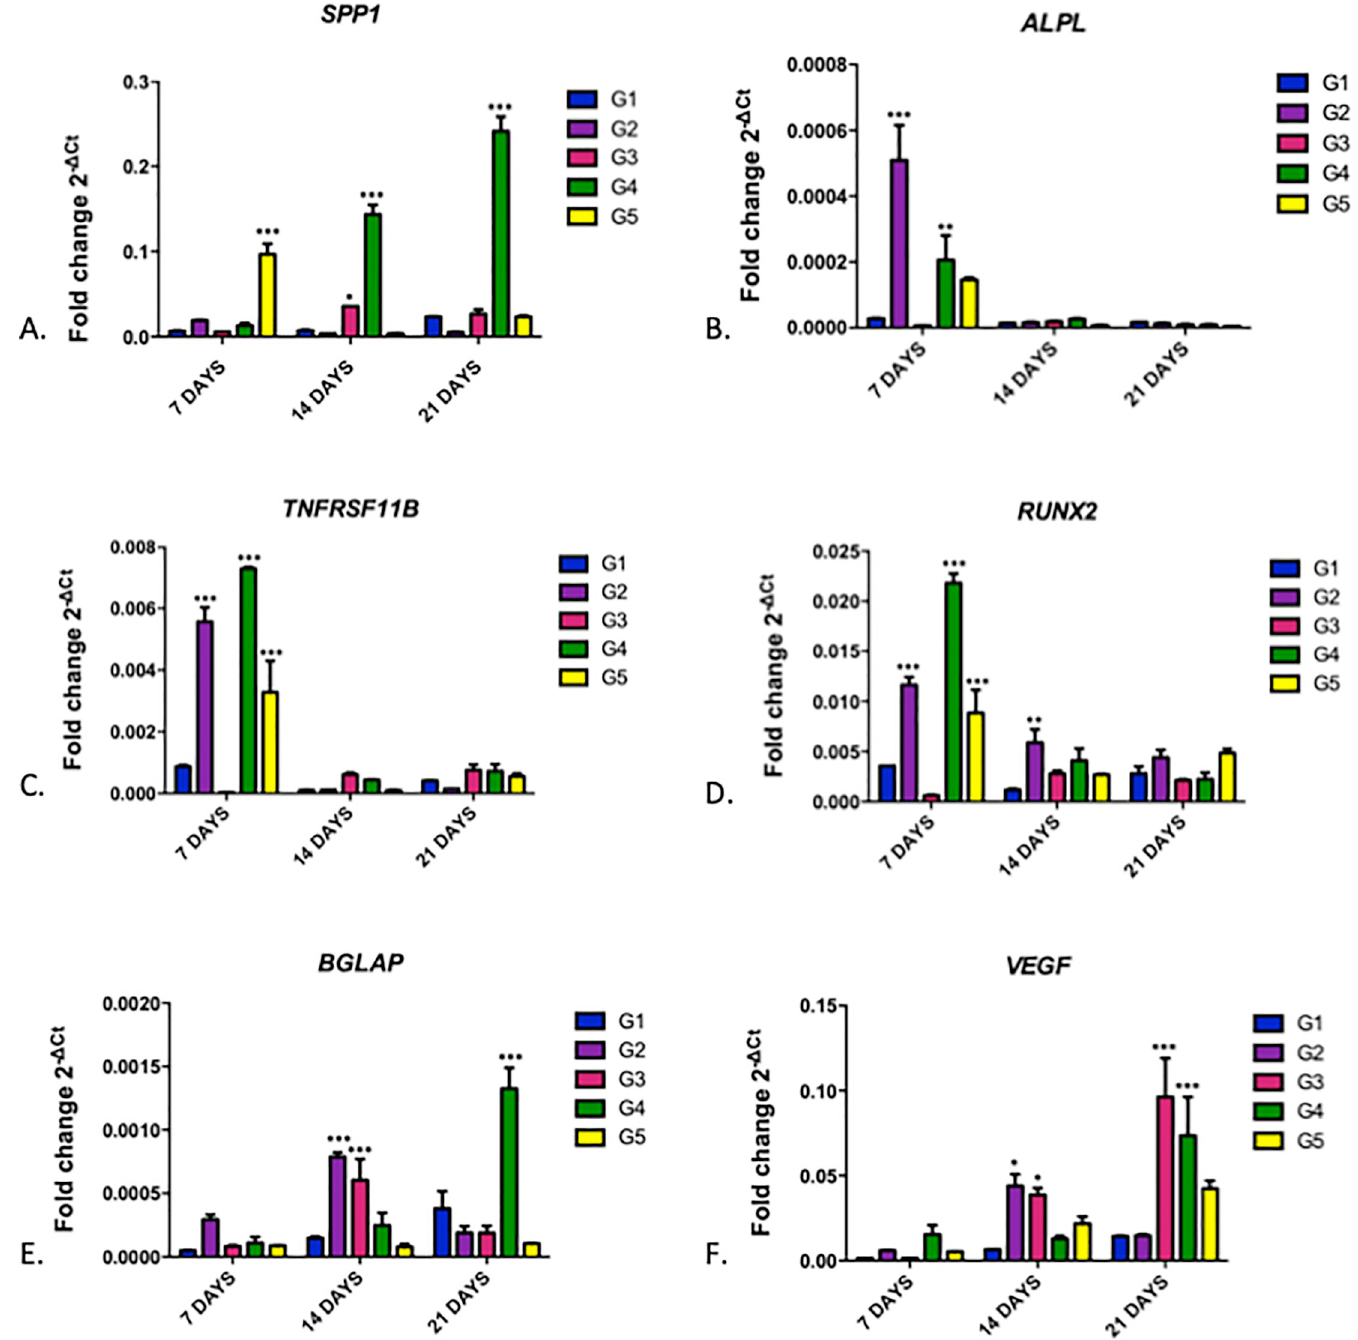
Fig 7. Quantitative RT-qPCR analysis of cultured MC3T3-E1 cells after G1, G2, G3, G4 and G5 group treatments over 7, 14, and 21 days, demonstrating gene expression of SPP1 (A), ALPL (B), TNFRSF11B (C), RUNX2 (D), BGLAP (E), and VEGF (F) genes normalized by the GAPDH gene. Bars indicate mean gene expression (2 - Δ Ct ) +/- standard error. Two-way ANOVA followed by the Bonferroni Test. ��� = p < 0.001; �� = p < 0.1, � = p < 0.05, compared to the control group (G1) for each period.